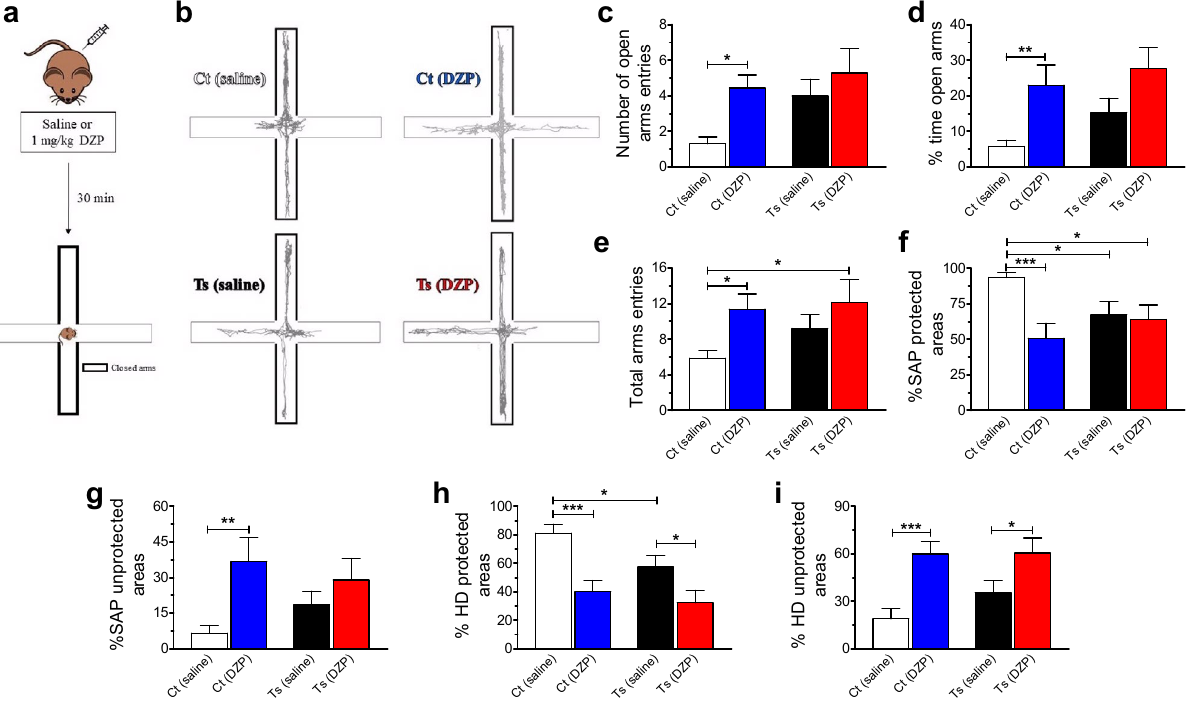
Figure 6. Ts65Dn mice show altered sensitivity to diazepam modulation of anxiety-like behavioral responses compared to control euploid mice. ( a ) Control and Ts65Dn mice were i.p. injected with either diazepam at 1-mg/kg dose (control, N = 16; Ts65Dn, N = 14) or saline (control, N = 16; Ts65Dn, N = 14) 30 min before testing in the EPM. ( b ) Representative trial trajectories of saline- and diazepam-treated mice exposed to EPM task. ( c , d ) Diazepam-treated control mice showed an increase in both the number of open arms entries ( c ) and the percentage of time spent in open arms ( d ) than vehicle-treated control mice. ( e ) Diazepam-treated control mice also showed an increase in total arms entries than vehicle-treated control mice. Regarding ethological parameters, ( f ) diazepam at 1-mg/kg dose decreased the percentage of stretched attend posture (SAP) in control mice compared with vehicle-treated control mice. Vehicle-treated Ts65Dn mice had significantly less protected SAP than vehicle-treated control mice. ( g ) Diazepam-treated control mice showed an increase in the percentage of unprotected SAP in control mice than vehicle-treated control mice. ( h ) Diazepam at 1-mg/ kg dose also decreased the percentage of head-dipping (HD) in both control and Ts65Dn mice compared with their respective vehicle-treated peers. Vehicle-treated Ts65Dn mice had lesser protected HD than vehicle- treated control mice. ( i ) Both control and Ts65Dn mice treated with 1 mg/kg diazepam showed an increase in the percentage of unprotected HD compared with their respective vehicle-treated peers. Number of mice: Ct baseline (N = 16), Ct 1 mg/kg diazepam (N = 16), Ts baseline (N = 14), and Ts 1 mg/kg diazepam (N = 14). Data represent mean ± SEM. Statistical significance is expressed as *, ** and *** for P < 0.05, P < 0.01, and P < 0.001, Next, we assessed the frequency of head-dipping (HD), which consists of an exploratory movement wherein the mouse projects its head/shoulders over the sides of the open arms and down towards the floor. As SAP, HD was also differentiated as protected or unprotected. Both genotype (F (1, 56) = 4.121, P = 0.0471) and treatment (F (1, 56) = 18.087, P = 0.0001) had significant effects on the percentage of protected HD [(protected/total) × 100]. No significant interaction was found between genotype and treatment (F (1, 56) = 1.058, P = 0.3082; Supplementary Table S13). Post hoc tests confirmed that vehicle-treated control mice performed protected HD most frequently than vehicle-treated Ts65Dn mice ( P = 0.0349) and diazepam-treated control mice ( P = 0.0003; Fig. 6g). Vehicle- treated Ts65Dn mice performed protected HD most frequently than diazepam-treated Ts65Dn mice ( P = 0.0314; Fig. 6g; Supplementary Table S14). Regarding the percentage of unprotected HD [(unprotected/total) × 100], treatment (F (1, 56) = 17.866, P = 0.0001), but not genotype (F (1, 56) = 1.214, P = 0.2752), had significant effects on this parameter. No significant interaction was found between genotype and treatment (F (1, 56) = 1.045, P = 0.3111; Sup- plementary Table S13). Post hoc tests showed that the percentage of unprotected HD was significantly higher for diazepam-treated control ( P = 0.0003) and Ts65Dn mice ( P = 0.0324; Fig. 6h; Supplementary Table S14) than for vehicle-treated mice of the same genotype. These findings indicated that diazepam-treated control and Ts65Dn mice exhibited a similar pattern of exploratory behavior, but vehicle-treated Ts65Dn mice appeared “less fear- ful” or “distressed” than vehicle-treated control mice when exposed to EPM. (Analyses on frequency of closed arm returns and grooming time can be found in Supplementary Fig. S5 and Supplementary Tables S13 and S14).